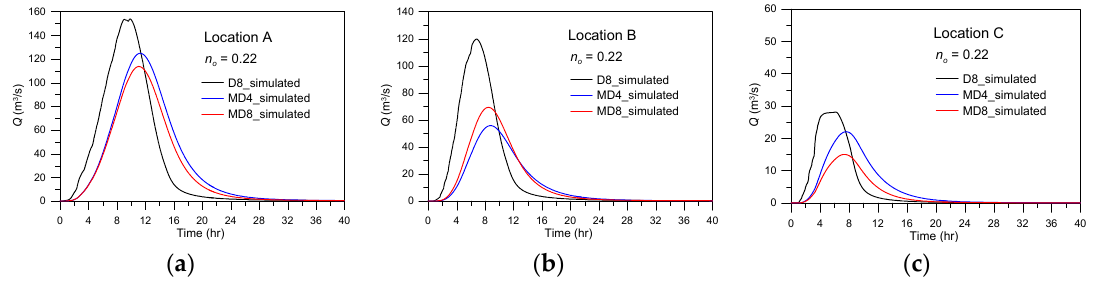
Figure 8. Simulated hydrographs based on different flow-direction methods at the three locations in the watershed: ( a ) Location A; ( b ) Location B; ( c ) Location C.